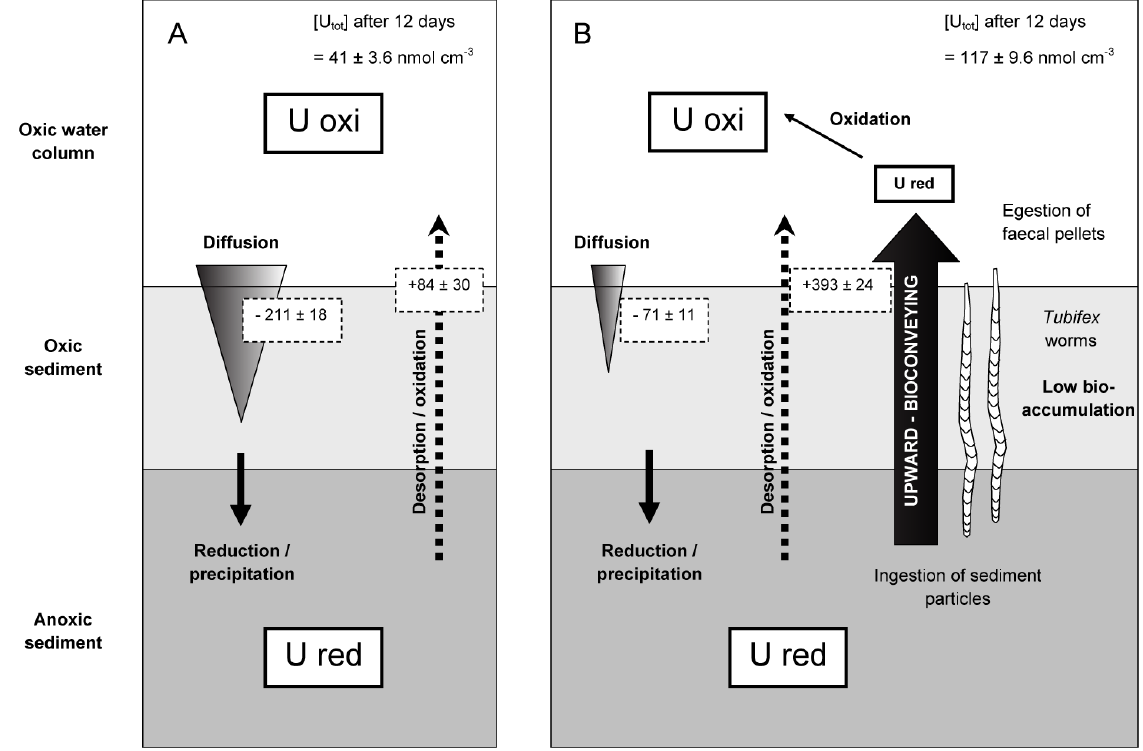
Figure 7. Conceptual outline of the repartition and transfers of U within a sediment without macro-invertebrate (A) or bioturbated by T. tubifex worms (B) under an oxygenated water column (U oxi = U in oxidized form, U red = U in reduced form). Framed values indicate the estimated fluxes of U over the 12 days of experiment (10 − 3 nmolcm − 3 h − 1 ) : diffusion values correspond to diffusive fluxes estimated with PROFILE software; outward flux values, i.e. desorption/oxidation ± removal by bioturbation, correspond to variation of U concentration in water column in [U-12] and [UT-12] aquaria,